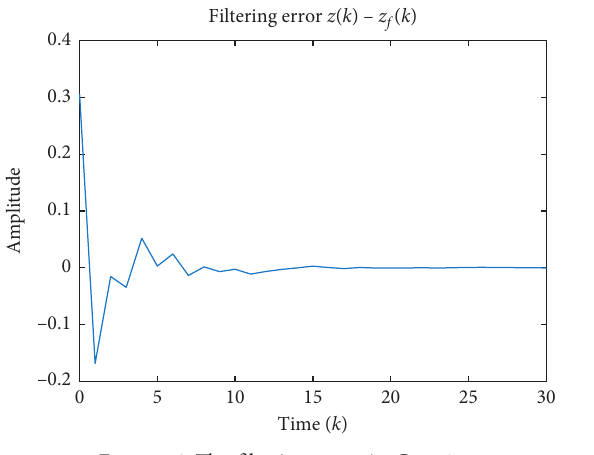
Figure 9: The filtering error in Example 2.